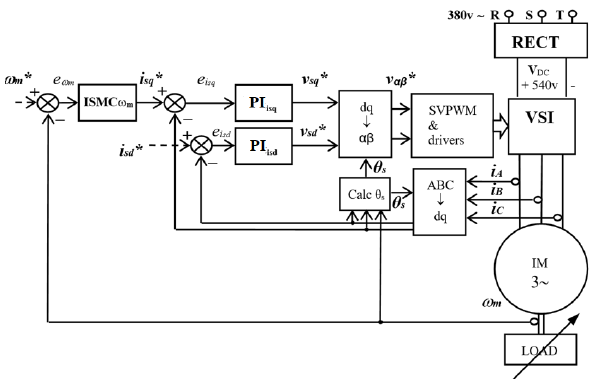
Figure 1. Block diagram of